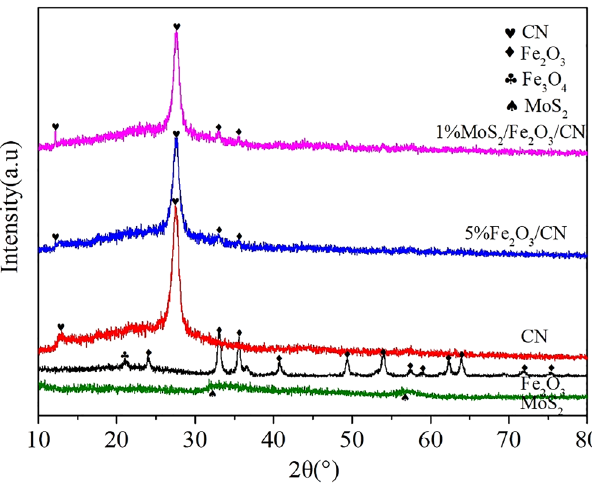
Figure 1. XRD pattern of CN, Fe 2 O 3 , MoS 2 , 5%Fe 2 O 3 /CN and 1%MoS 2 /Fe 2 O 3 /CN.